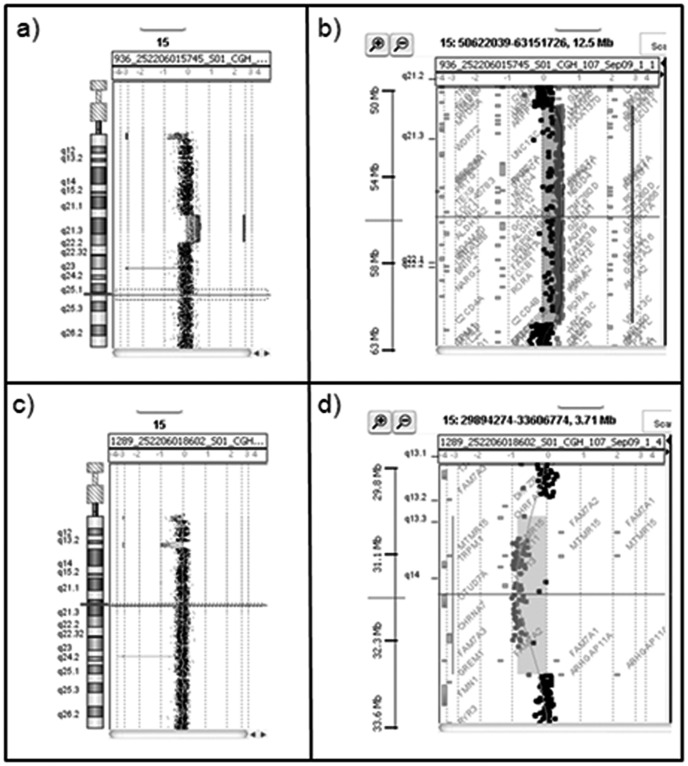
Family 1, array-CGH results.a) Array-CGH graphical overview of 15q21.2q22.2 duplication of the proposita. b) Enlargement of the duplicated region 15q21.2q22.2 spanned 10.5 Mb from oligonucleotide A_16_P03028573(51,604,508 bp) to A_16_P20273880 (62,102,756 bp). c) Array-CGH graphical overview of 15q13.2q13.3 deletion of the mother. d) Enlargement of the deleted region spanned 2.262 Mb from oligonucleotide A_18_P12164655 (30,652,489 bp) to A_14_P200747 (32,914,140 bp).